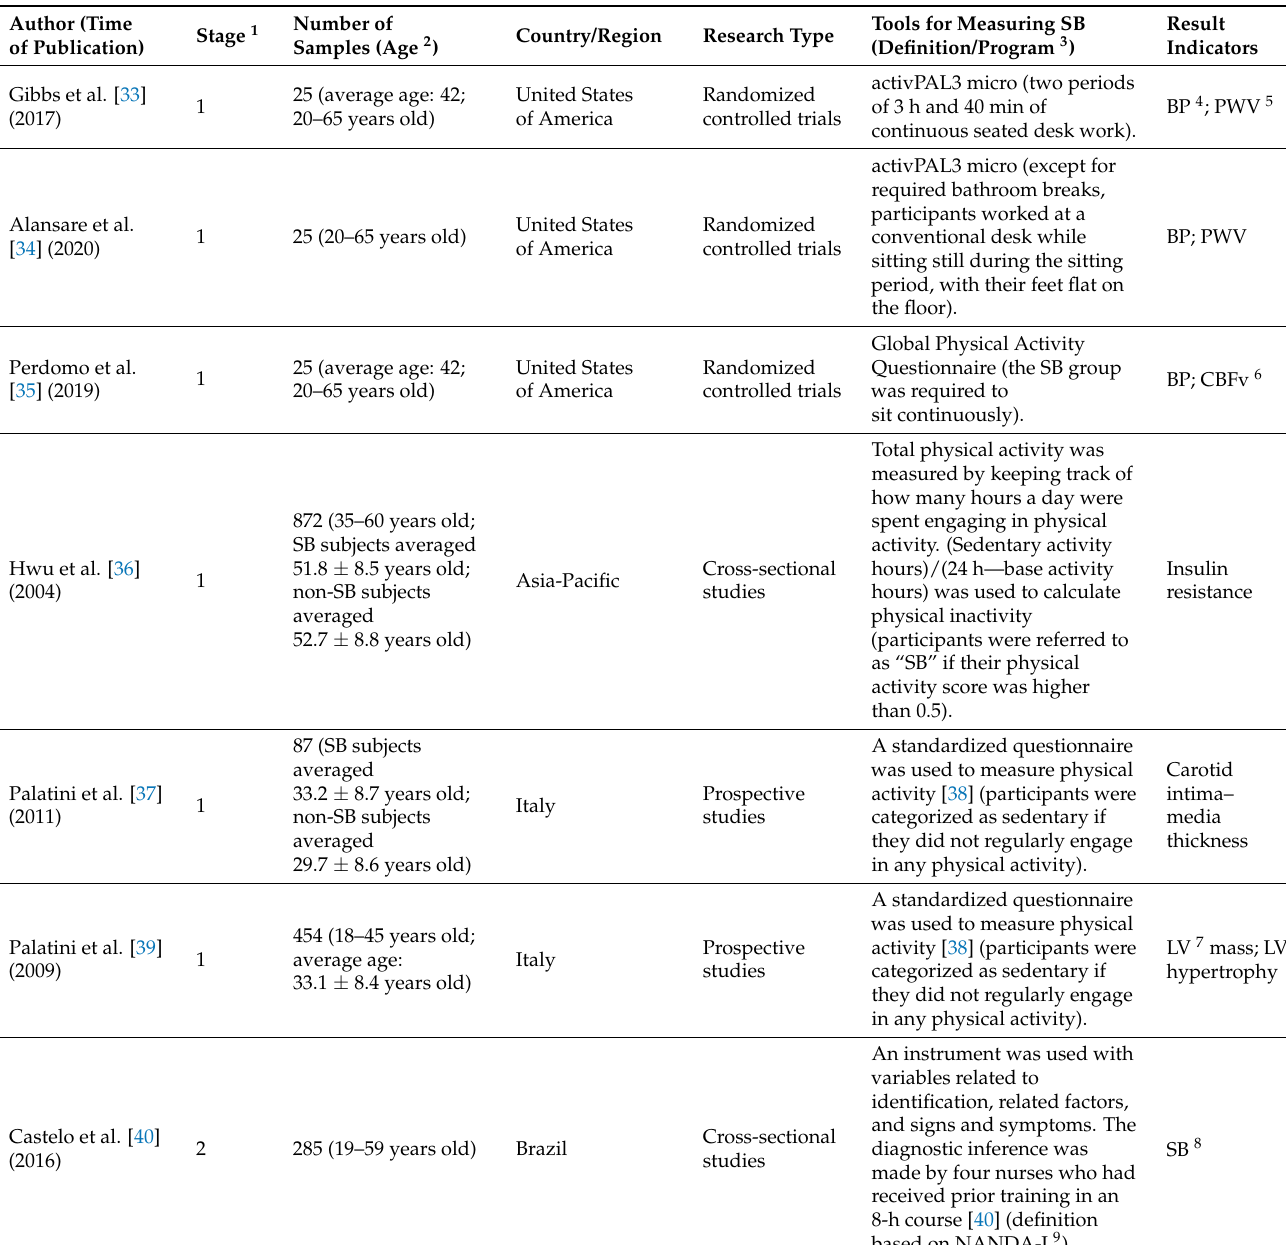
Table 1. Basic characteristics of the literature for inclusion in this